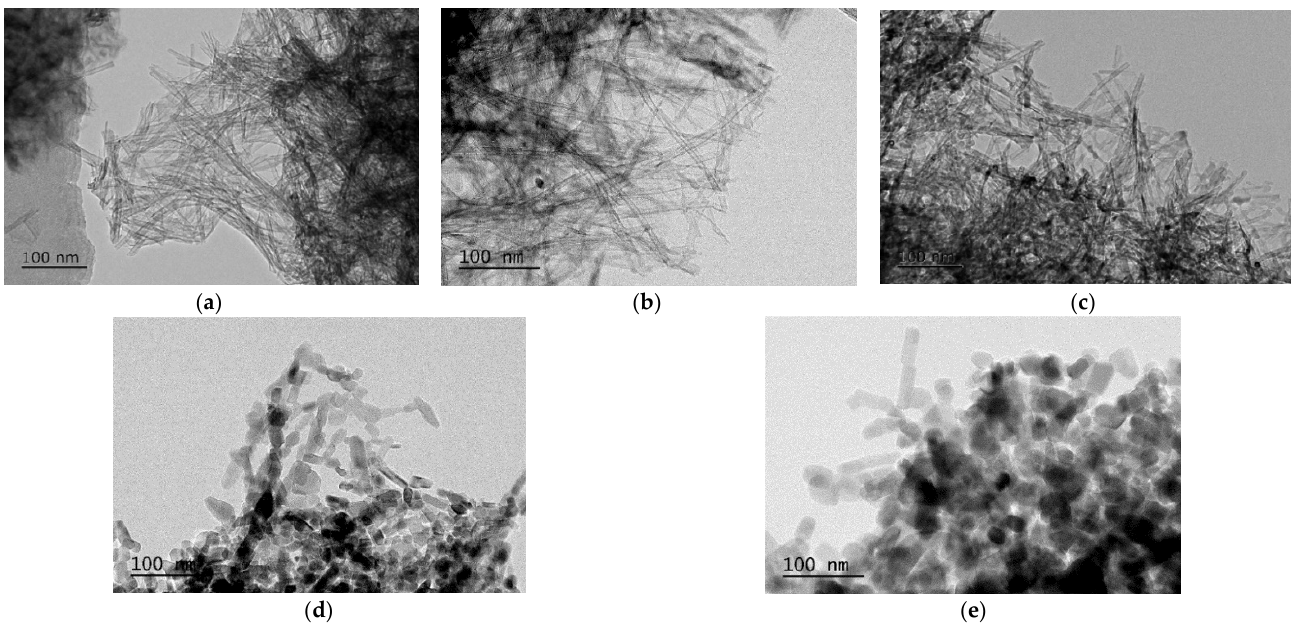
Figure 2. TEM images of the ( a ) TNT-100, ( b ) TNT-350, ( c ) TNT-450, ( d ) TNT-550, and ( e ) TNT-650 photocatalysts.